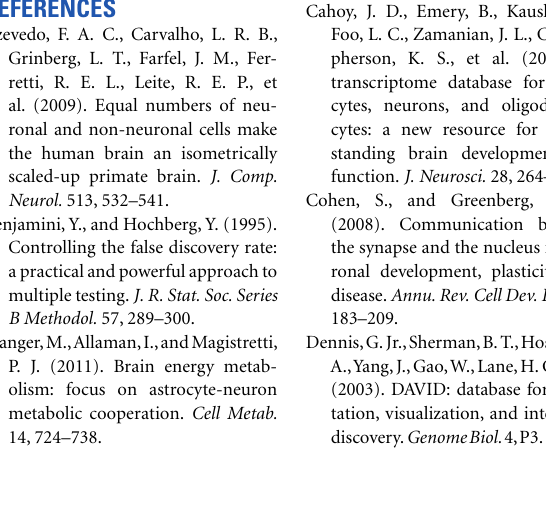
Table S1 | Orthologous human brain annotations. Table S2 | Orthologous mouse brain annotations. Table S3 | H0351.2002 PC1 gene loadings. Table S4 | H0351.2001 brain loadings. Table S5 | H0351.2002 brain loadings.